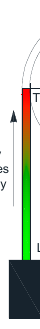
Figure 18. A sketch of load variation along rope length.